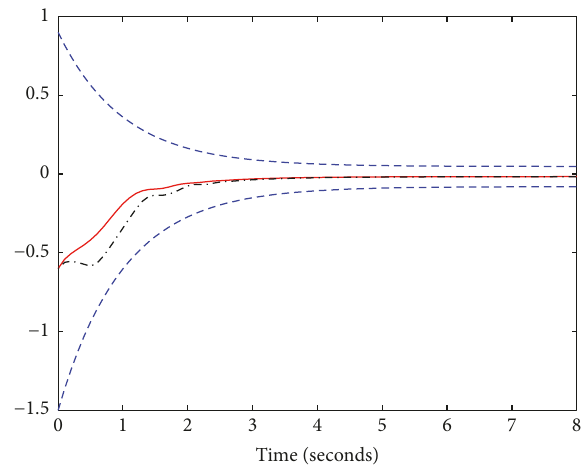
𝑇 𝑆(𝑍) (- ⋅ - ⋅ ). Figure 11: Angular position tracking error 𝑒 11 : neural learning 2 control (—), ANC (- ⋅ - ⋅ ), and the error bounds (- - -).